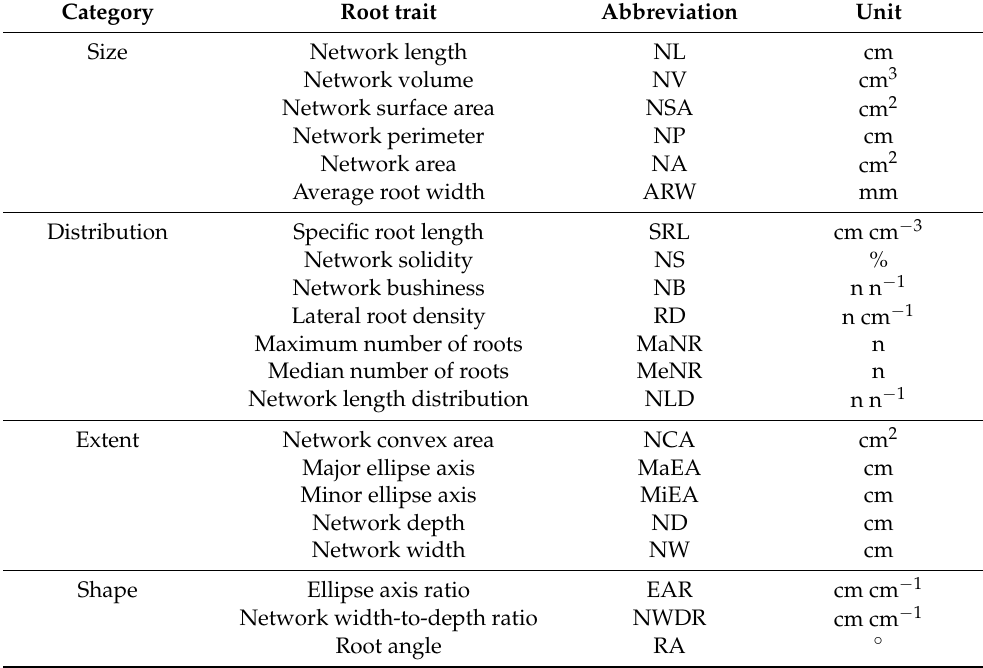
Table 1. Root-system traits used for root analysis in mini-rhizotrons with categories after Topp et al. (2013), abbreviation and unit, analyzed with GiA Roots (Galkovskyi et al. 2012) and the ImageJ plugin SmartRoot (lateral root density, root angle; Lobet et al.